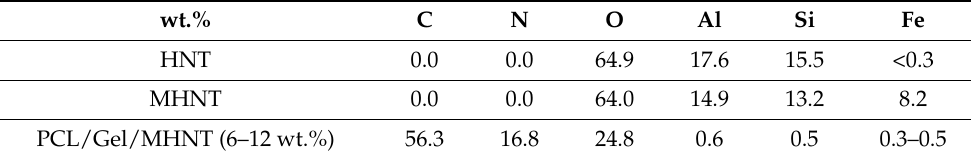
Table 1. EDX analysis of HNT, MHNT, and PCL/Gel/MHNT nanofibers (average values, the table